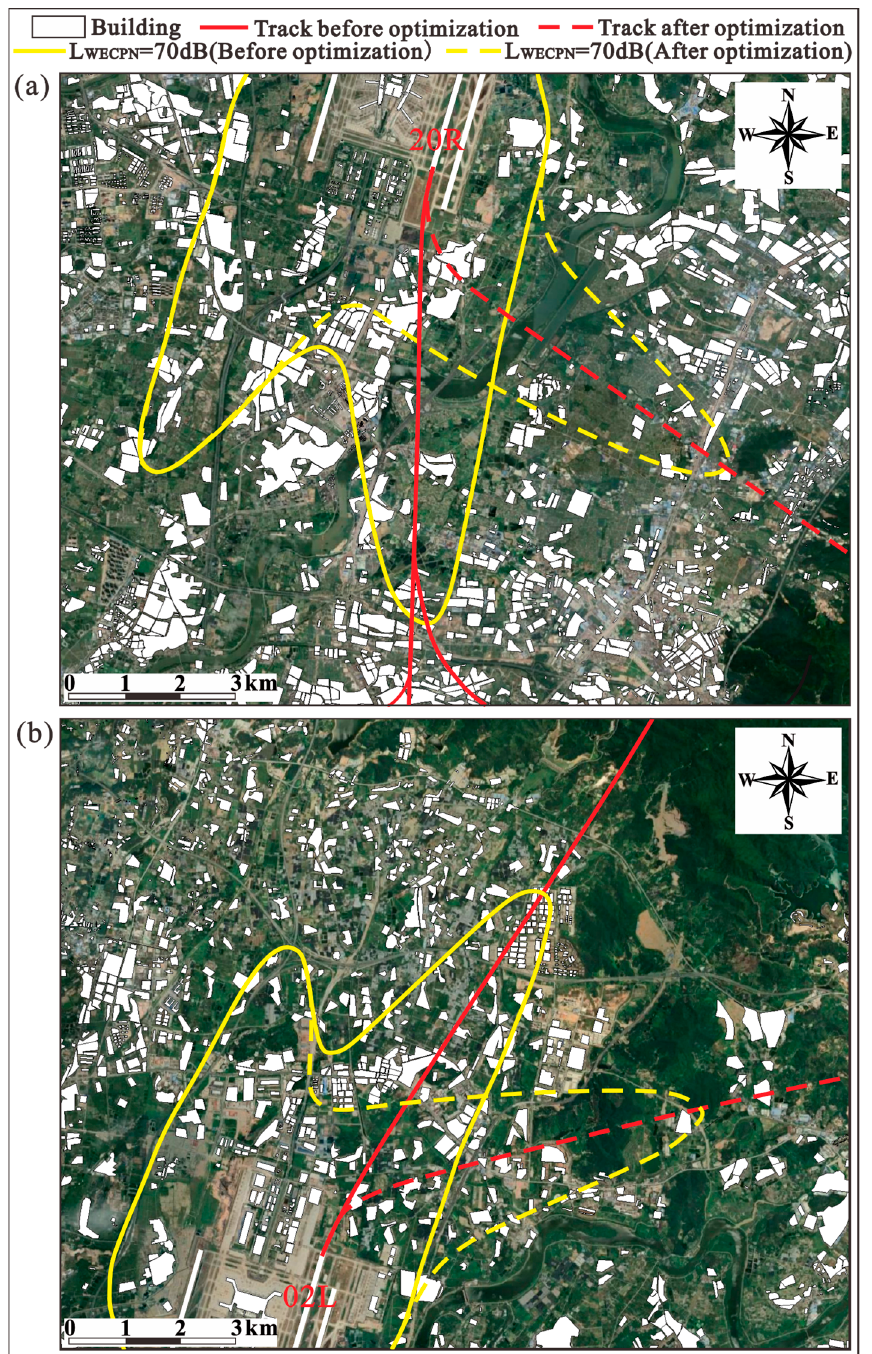
Figure 8. Noise contours before and after optimization of flight procedure during ( a ) summer and ( b ) winter.